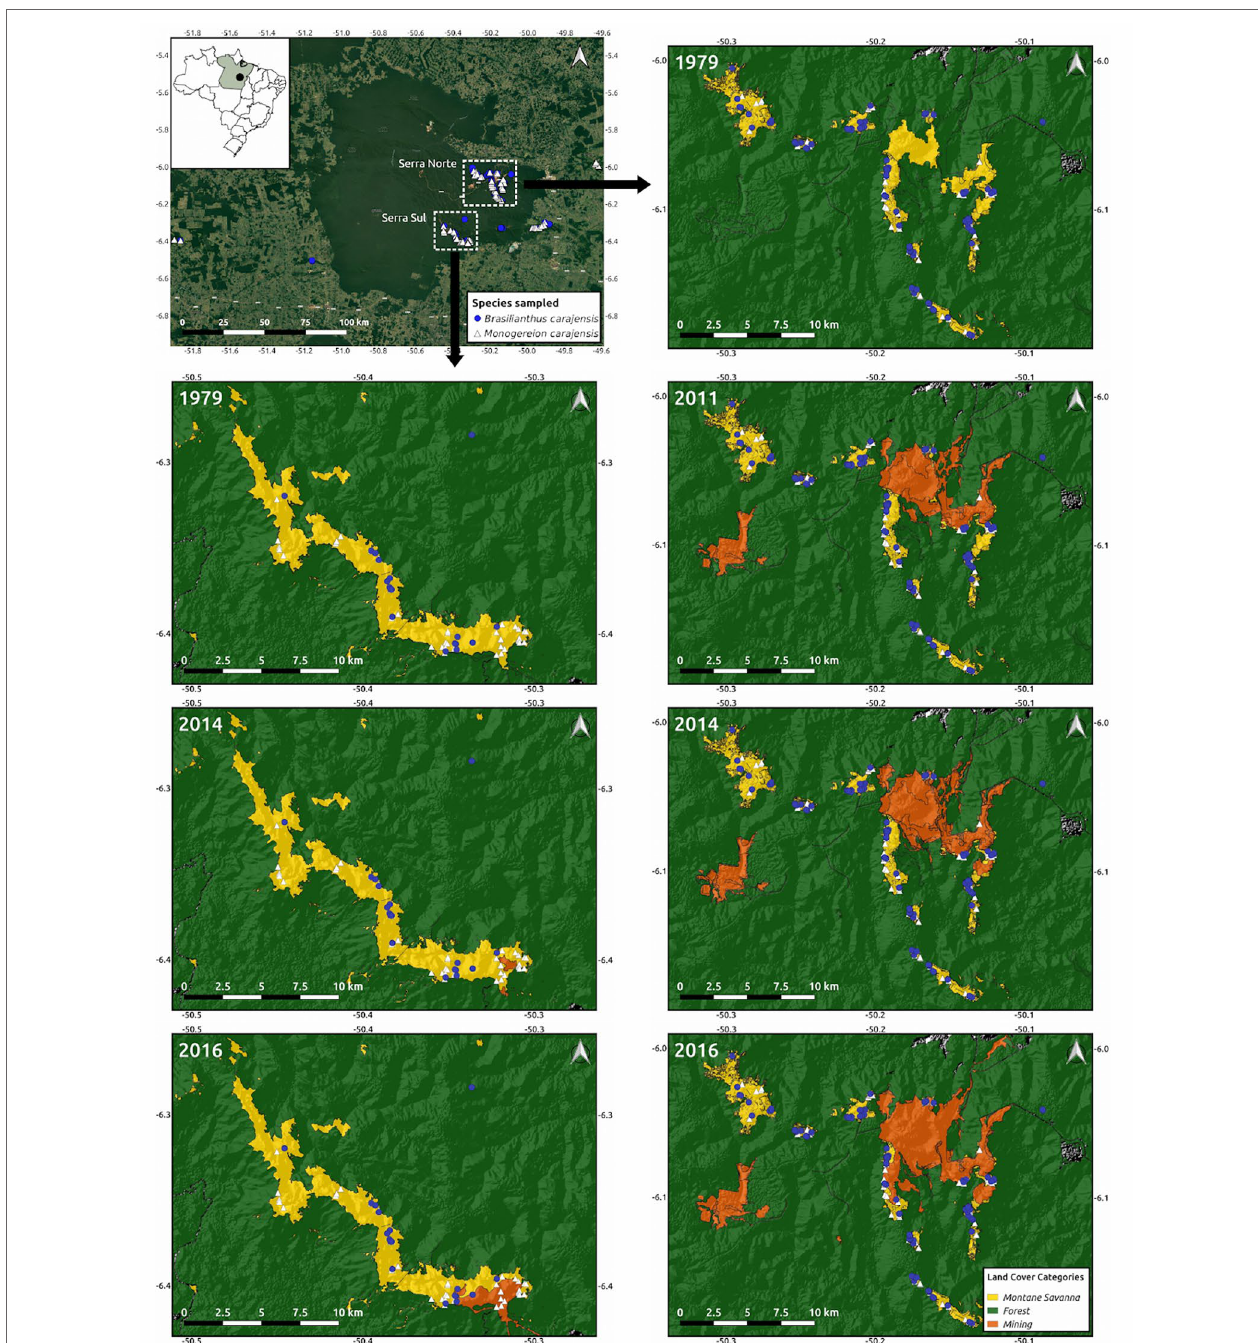
FiGURE 1 | Map of the study region depicting the location of the collected samples from Brasilianthus carajensis (blue circles) and Monogereion carajensis (white triangles) in Serra Norte (right panels) and Serra Sul (left panels). Hill shade maps are shown overlaid with land cover color maps for the different years analyzed. The location of the Carajás Mineral Province within Brazil is shown on the upper left